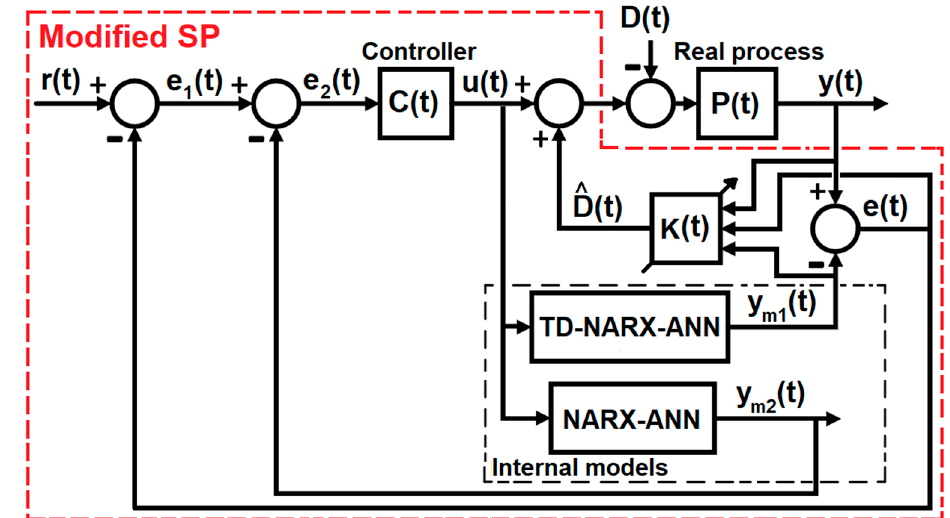
Figure 9. Proposed modified structure of the SP.